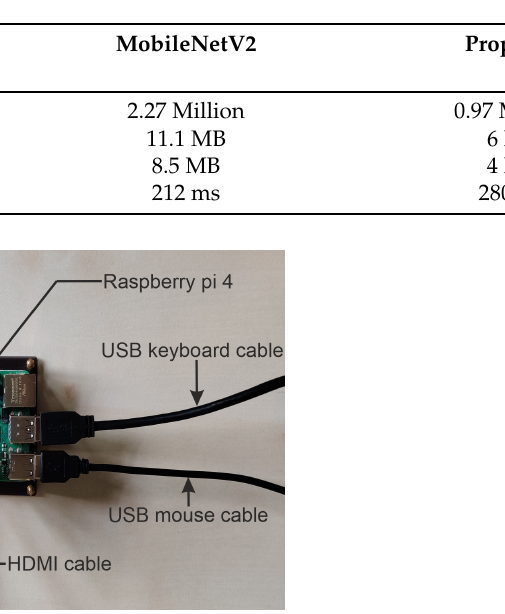
Table 6. Comparison of Deep learning models considered in this work for deploying in the edge computing device (Raspberry pi 4 model B). Note that notation wise, TF represents Tensorflow and TFL represents‘ Tensorflow-Lite.